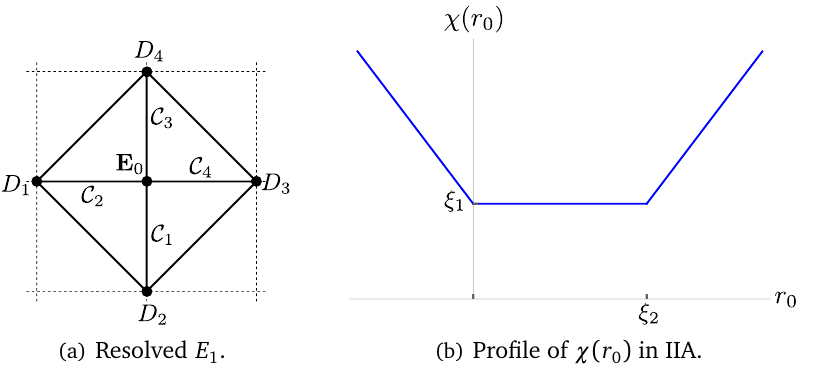
singularity and its vertical reduction. We have ξ 1